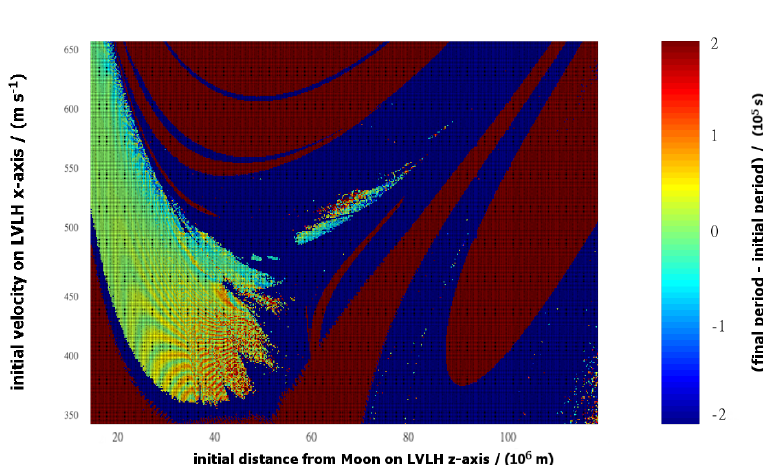
Figure 14. The final period between crossings of the LVLH y – z plane for those initial conditions that produced 30-year-stable trajectories. The time interval is shown in seconds on the color-axis as a function of the initial state. The horizontal axis represents the initial poisiton (meters), measured along the LVLH z -axis; the vertical axis represents the initial velocity (m/s), directed parallel to the LVLH x -axis. For reference, 1 sidereal month is approximately 2.4 × 10 6 s. This plot can also be used to identify the 30-year-stable initial conditions. As such, it is similar to Figure 11, but provides more detailed coverage of the initial states.